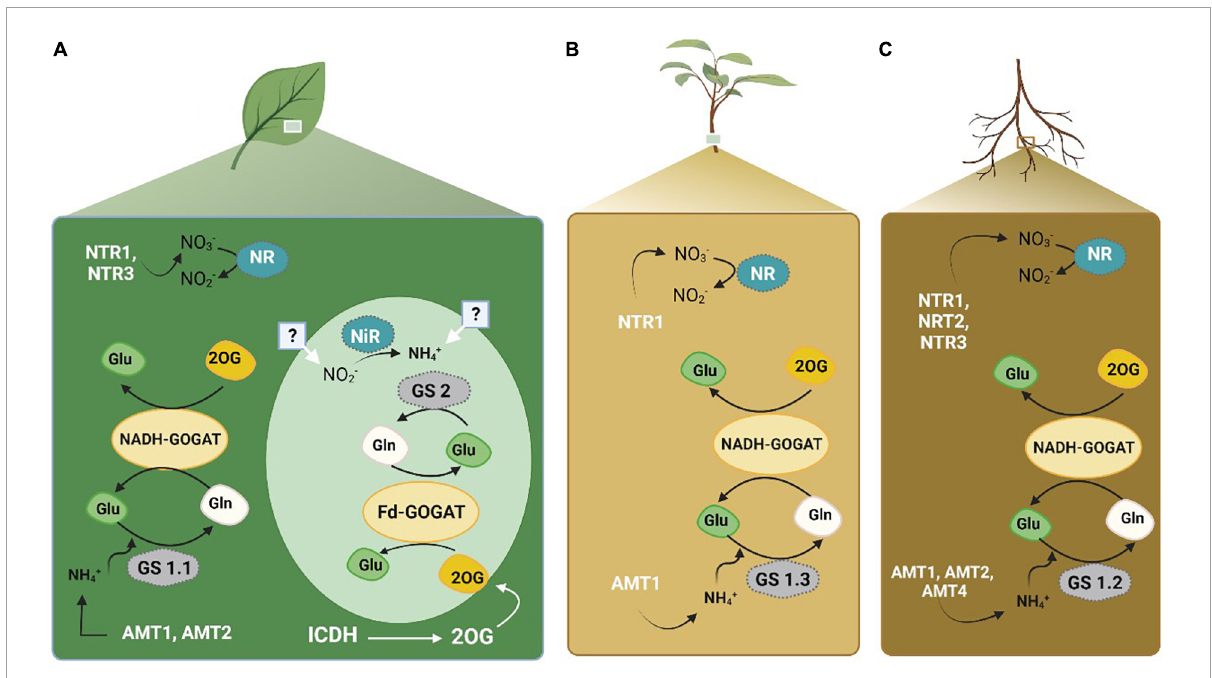
FIGURE3 Nitrogen transporters and key enzymes involved in N metabolism and acquisition in plants. Panel (A) represents the activity in leaves. Panel (B) represents the activity in plant. Panel (C) represents the activity within the roots. The figure created with Biorender (https://biorender.com/).